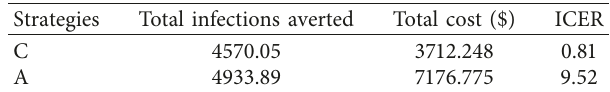
Table 5: Total amount of the infection averted and total cost with their ICER.